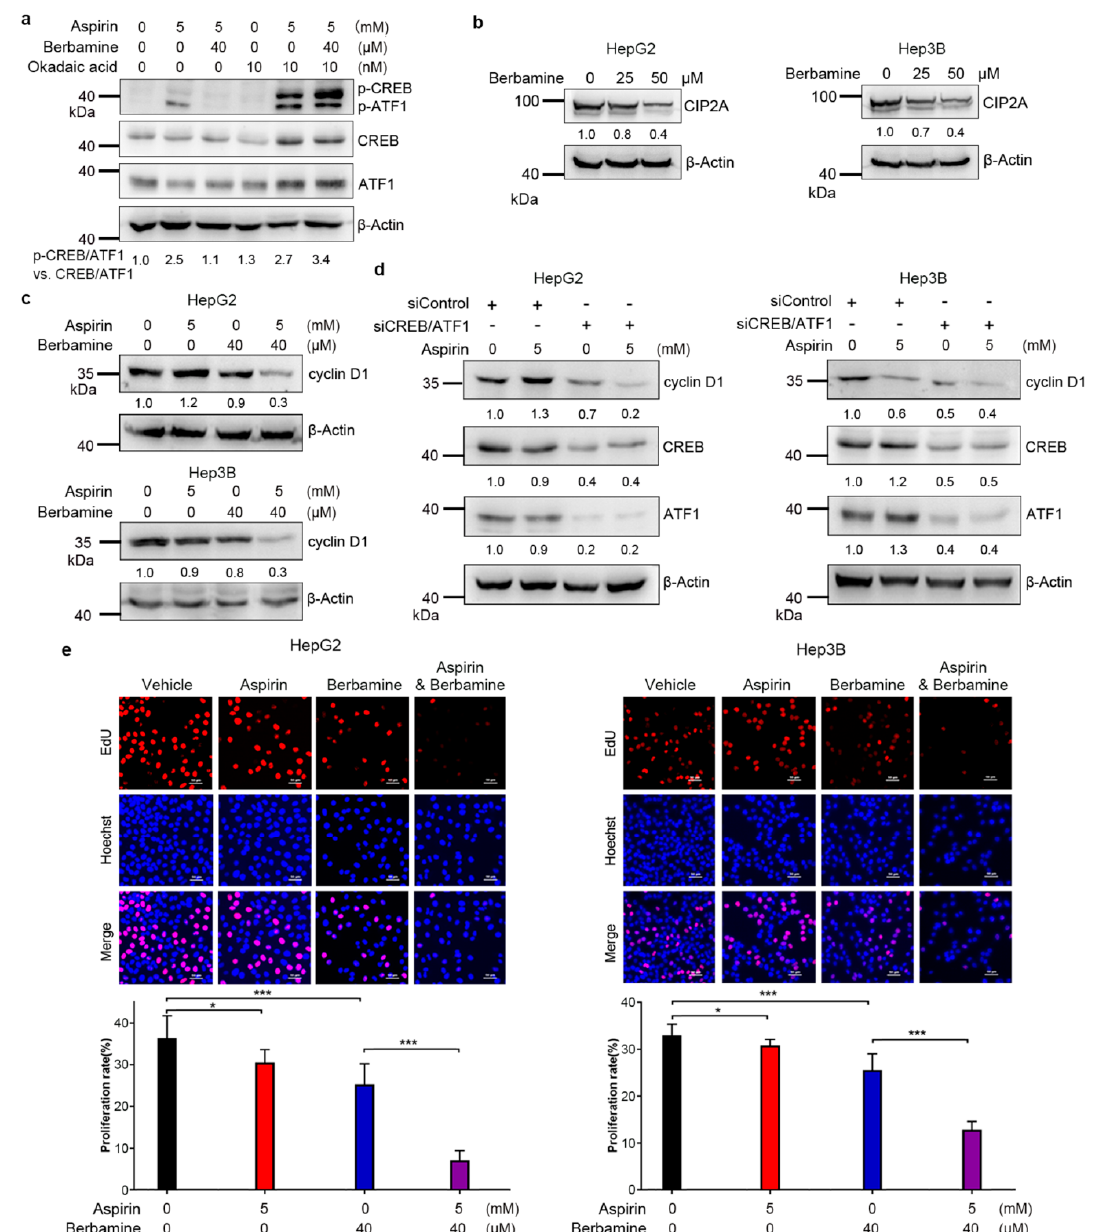
Figure 6. Berbamine inhibits protein phosphatase 2A (CIP2A) expression, promotes PP2A-mediated CREB/ATF1 dephosphorylation, and potentiates the inhibition of cyclin D1 expression in HCC cells. ( a ) HepG2 cells were treated with or without aspirin, berbamine and okadaic acid, followed by western blot analysis of CREB/ATF1 phosphorylation. The relative levels of p-CREB/ATF1 normalized to total CREB/ATF1 were shown. ( b ) HepG2 and Hep3B cells were treated with indicated doses of berbamine, followed by western blot analysis of CIP2A. The relative levels of CIP2A were shown. ( c ) HepG2 and Hep3B cells were treated with aspirin and/or berbamine for 48 h, followed by western blot analysis of cyclin D1 expression. The relative levels of cyclin D1 were shown. ( d ) HepG2 and Hep3B cells were transfected with siControl or siCREB/ATF1 and treated with or without aspirin for 48 h, followed by western blot analysis of indicated proteins. The relative levels of cyclin D1, CREB and ATF1 were shown. ( e ) HepG2 and Hep3B cells were treated with aspirin individually or in combination with berbamine for 48 h, followed by detecting proliferative cells with EdU assays. Scale bar, 50 µ m. The proliferation rate was plotted. Values represent means ± SD ( n = 3). ***, p <